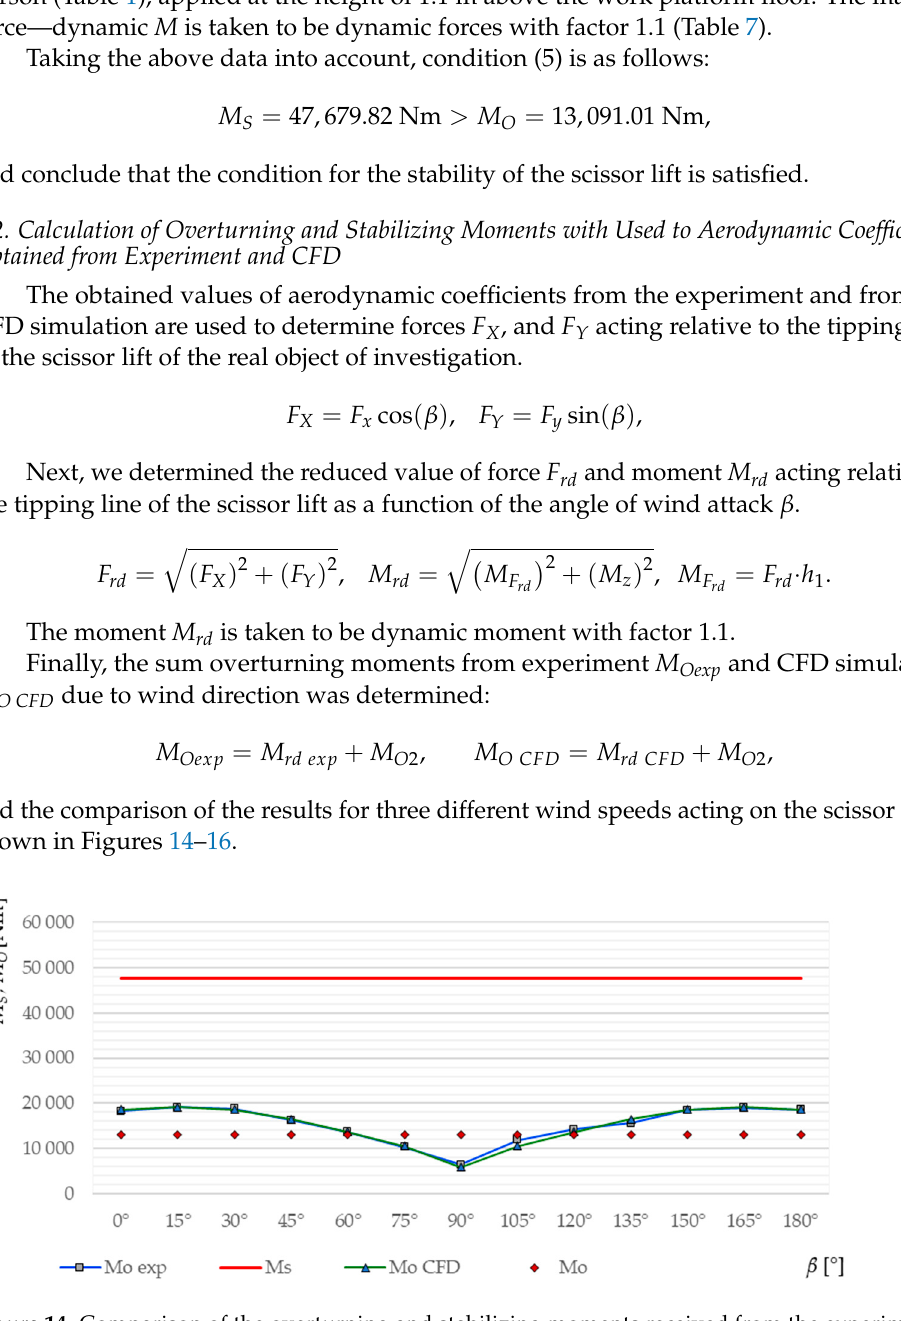
Figure 14. Comparison of the overturning and stabilizing moments received from the experimental and numerical tests with the calculation based on [17] for the wind speed V = 12.5 m/s (config. 1).